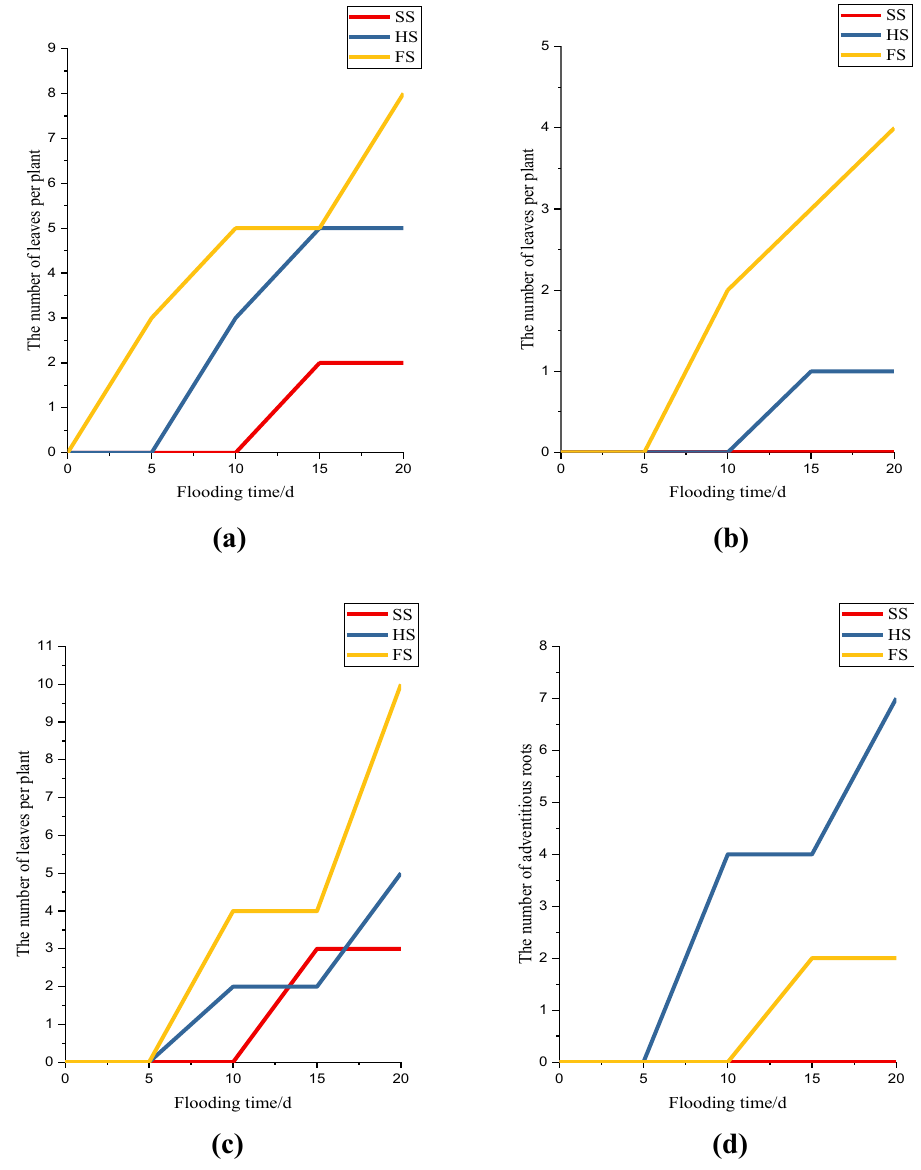
Figure 1. Effect of submergence stress on leaf morphology in Morus alba : ( a ) The number of curled or wilted leaves per plant; ( b ) The number of brown spots or rotten leaves per plant; ( c ) The number of fallen leaves per plant; ( d ) The number of adventitious roots. This figure was drawn using Origin Pro 2021 v.